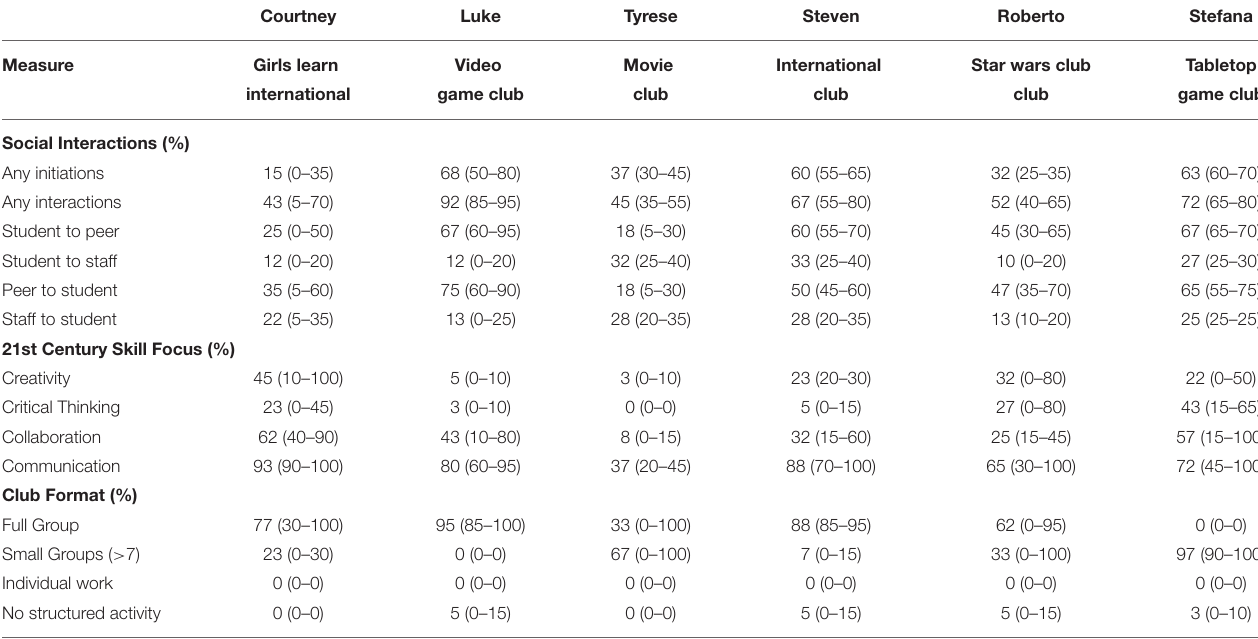
TABLE 4 | Summary of observational data across